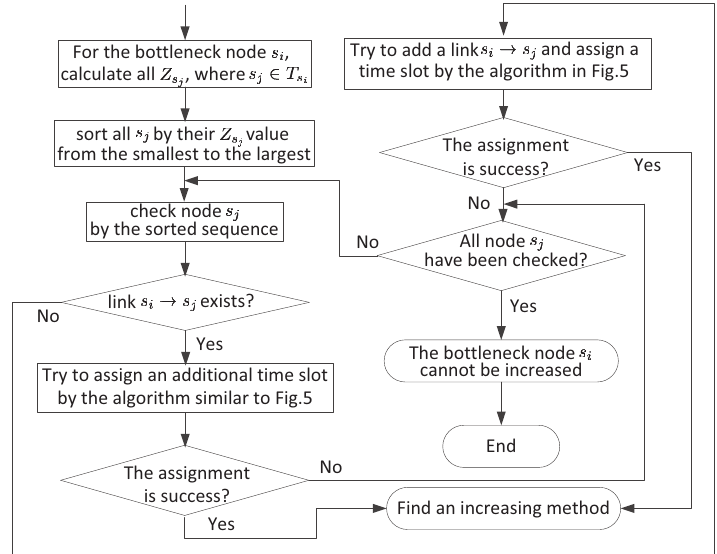
Figure 6. Increase bottleneck node s i ’s